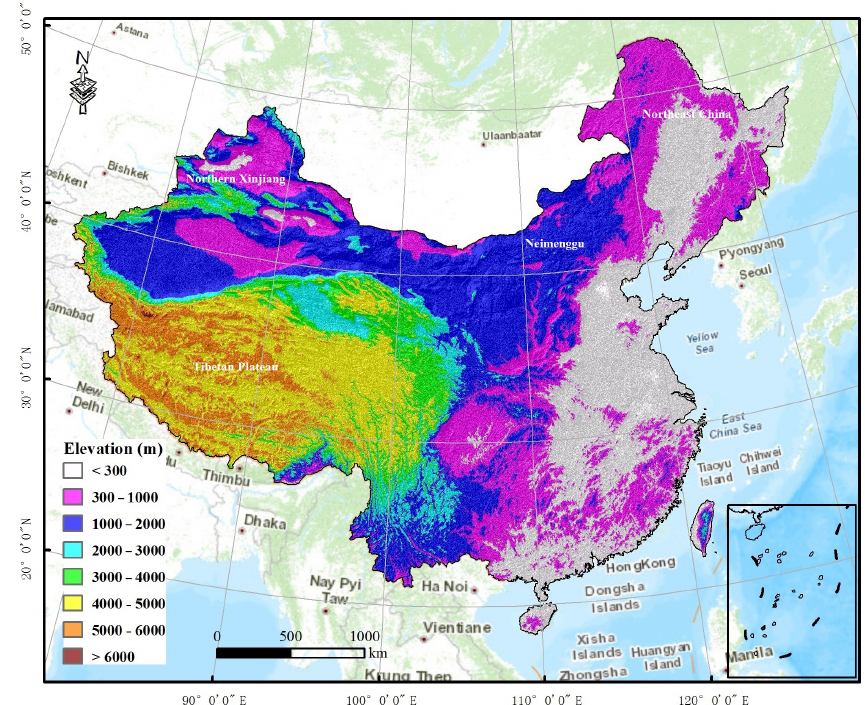
Figure 1. Schematic diagram of the study